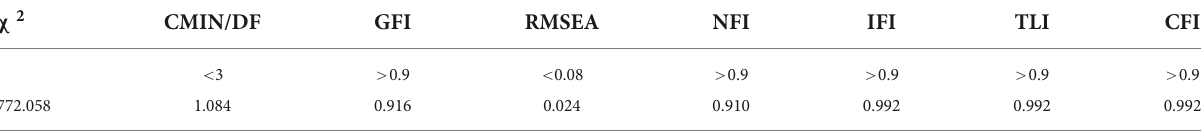
TABLE 4 Goodness-of-fit indices of the measurement